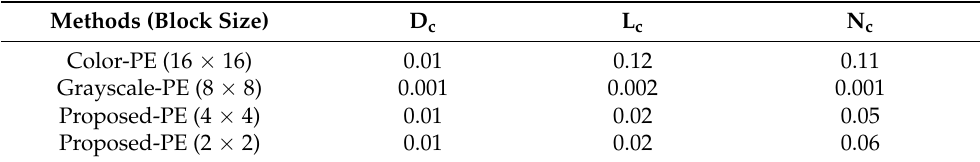
Table 3. Robustness analysis of block-based perceptual encryption methods against jigsaw puzzle solver attack in terms of direct comparison (D c ), largest component comparison (L c ) and neighbor comparison (N c ).